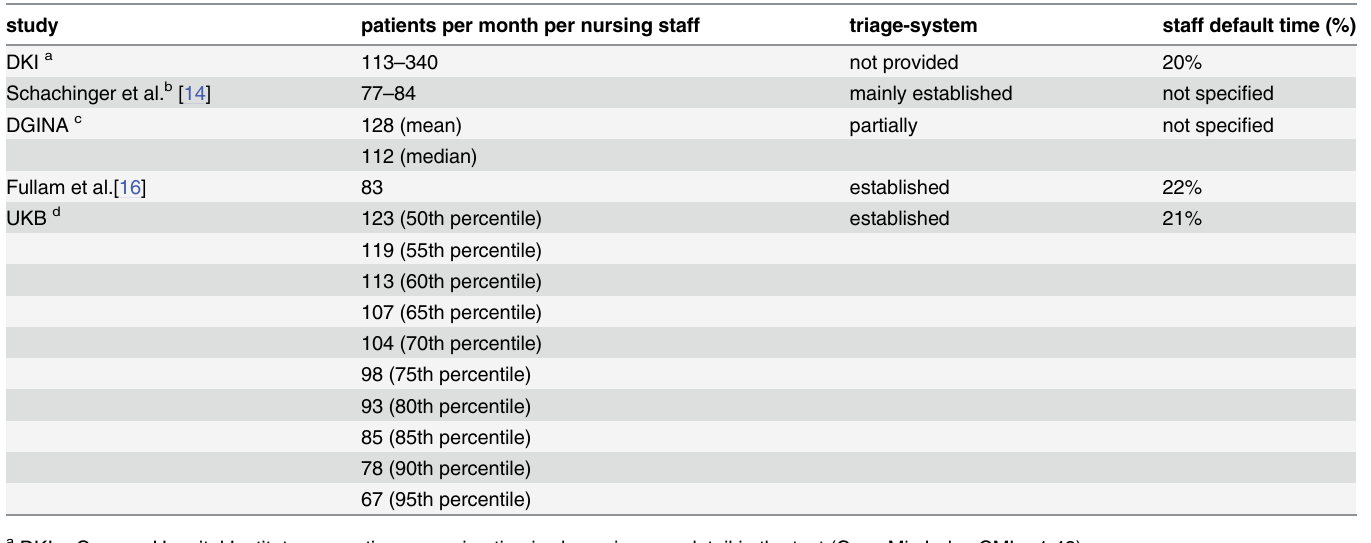
Table 3. Required for full-time staff depending on different methods of